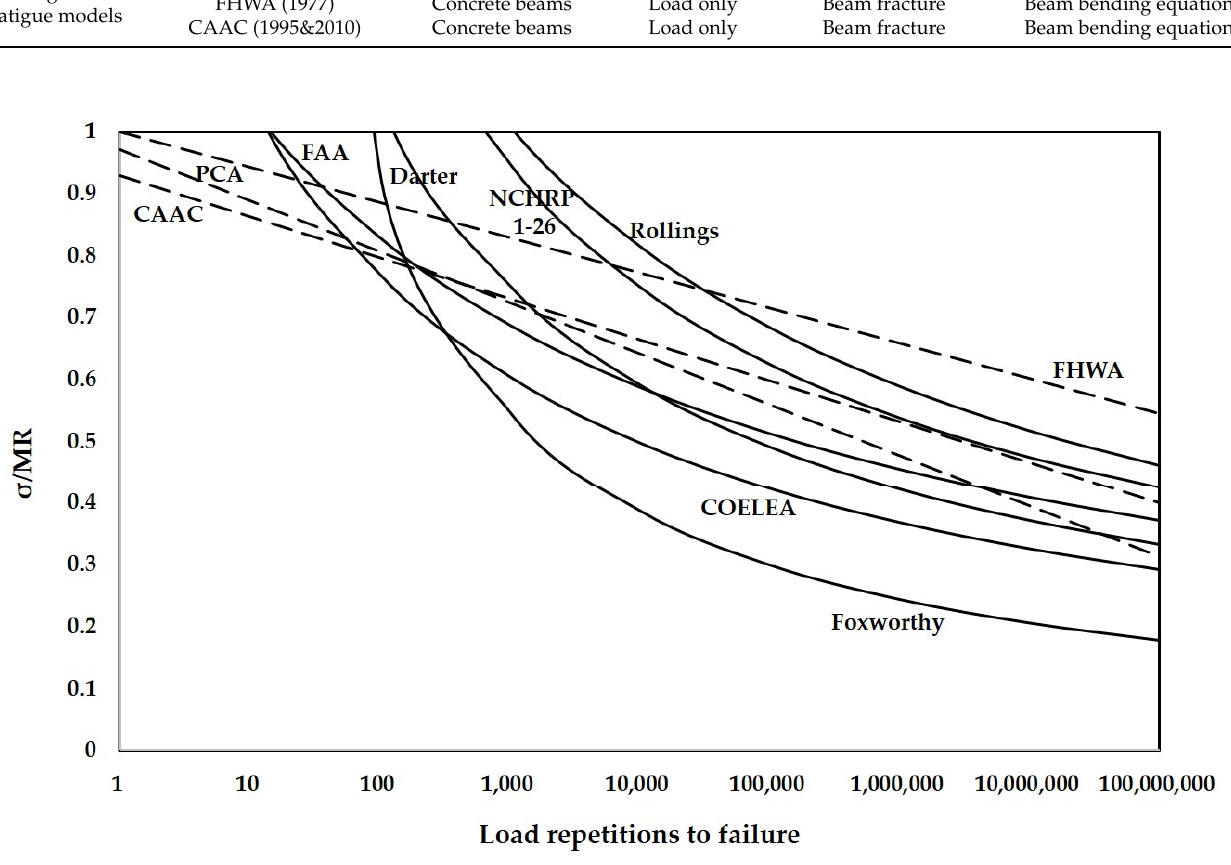
Figure 5. Fatigue curves of the fatigue models involved in this